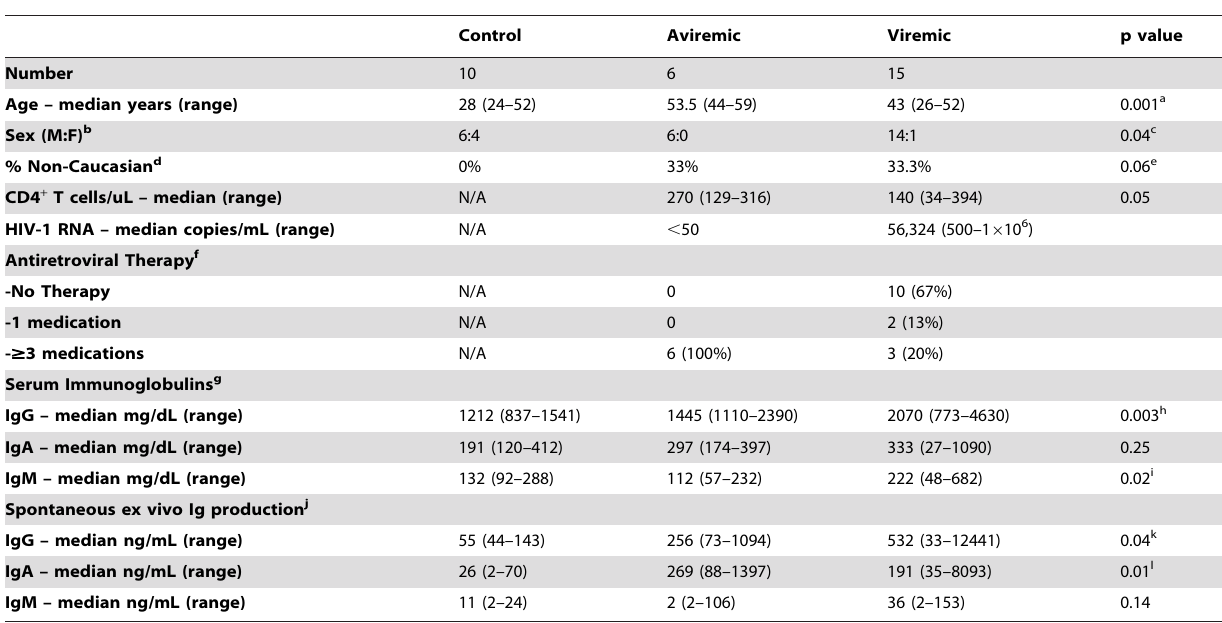
Overall p values are listed on the table. a Secondary analysis: control vs. aviremic p , 0.0001, all other comparisons p . 0.05. b Effect of gender was evaluated by Chi Square test. c Secondary analyses were calculated by Fisher’s exact test: control vs. aviremic p=0.23, control vs. viremic p=0.12, aviremic vs. viremic p=1.00. d Non-Caucasian=African-American, Asian/Pacific Islander, Native American, Hispanic, or Other; overall p value calculated by Chi Square test. e Secondary analyses were calculated by Fisher’s exact test: control vs. aviremic p=0.04, control vs. viremic p=0.06, aviremic vs. viremic p=0.63. f Antiretroviral therapy: 1 medication=NRTI, $ 3 medications=1 PI + 2 NRTI or NNRTI + 2 NRTI. g Control n=9, aviremic n=6, viremic